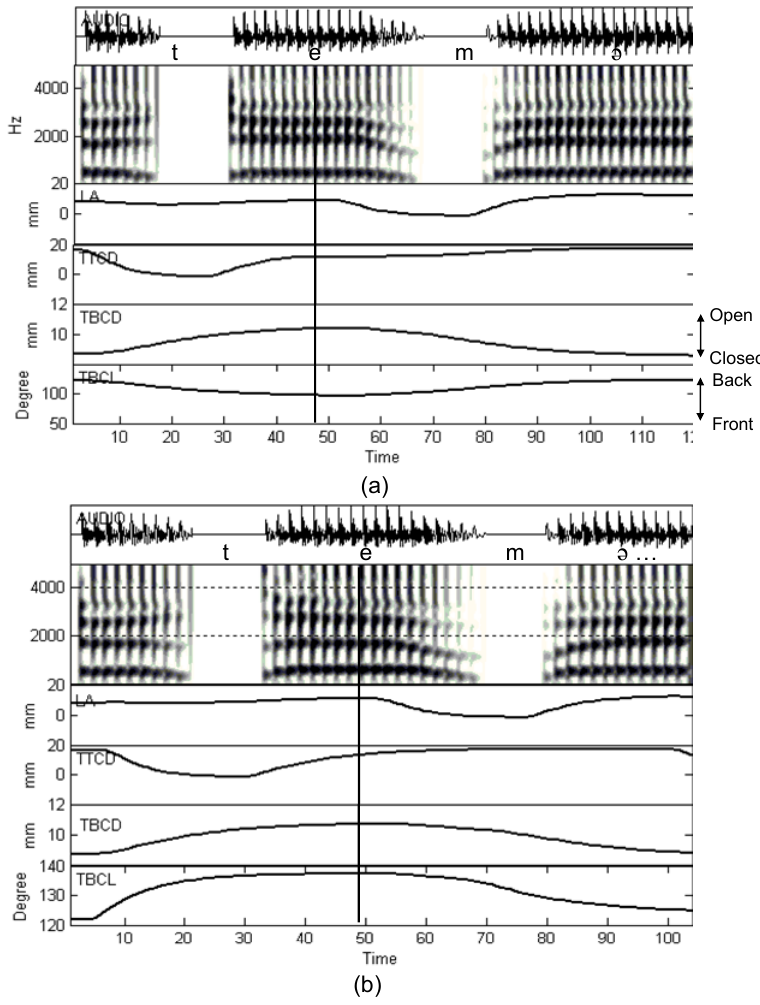
Figure 2. Articulatory trajectories computed to satisfy the representations shown in Figure 1, and corresponding acoustic outputs: Lip Aperture (LA) for /m/, Tongue Tip Constriction Degree (TTCD) for /t/, Tongue Body Constriction Degree (TBCD) and Tongue Body Constriction Location (TBCL) for the vowels of interest. (a) Modeled underived /e/ in ['te.m ə ]’homework; (b) Modeled blended /e/ in [te.m ə .{'tor}]’the evening show’. The gestures in curly brackets are not shown (the gestures and acoustic signal for [ ə ] are only partially shown). The vertical continuous lines show the approximate location used for the acoustic